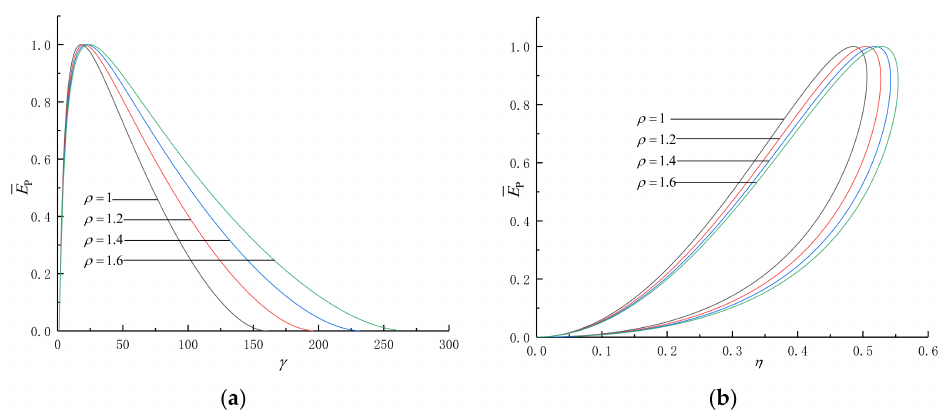
Figure 2. Effects of τ on E P − γ and E P − η . ( a ) Variation of E P with γ . ( b ) Variation of E P with η .